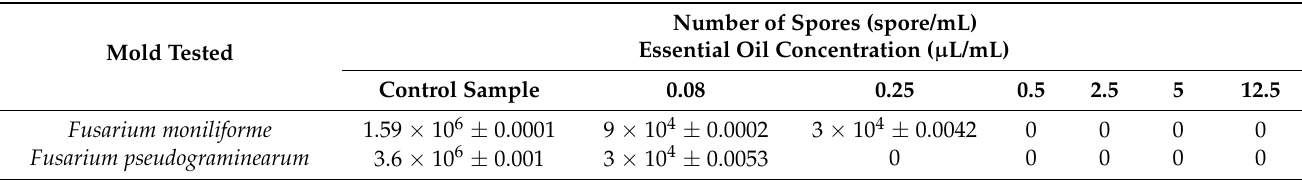
Table 4. Effect of M. vulgare essential oil on sporulation of tested molds.